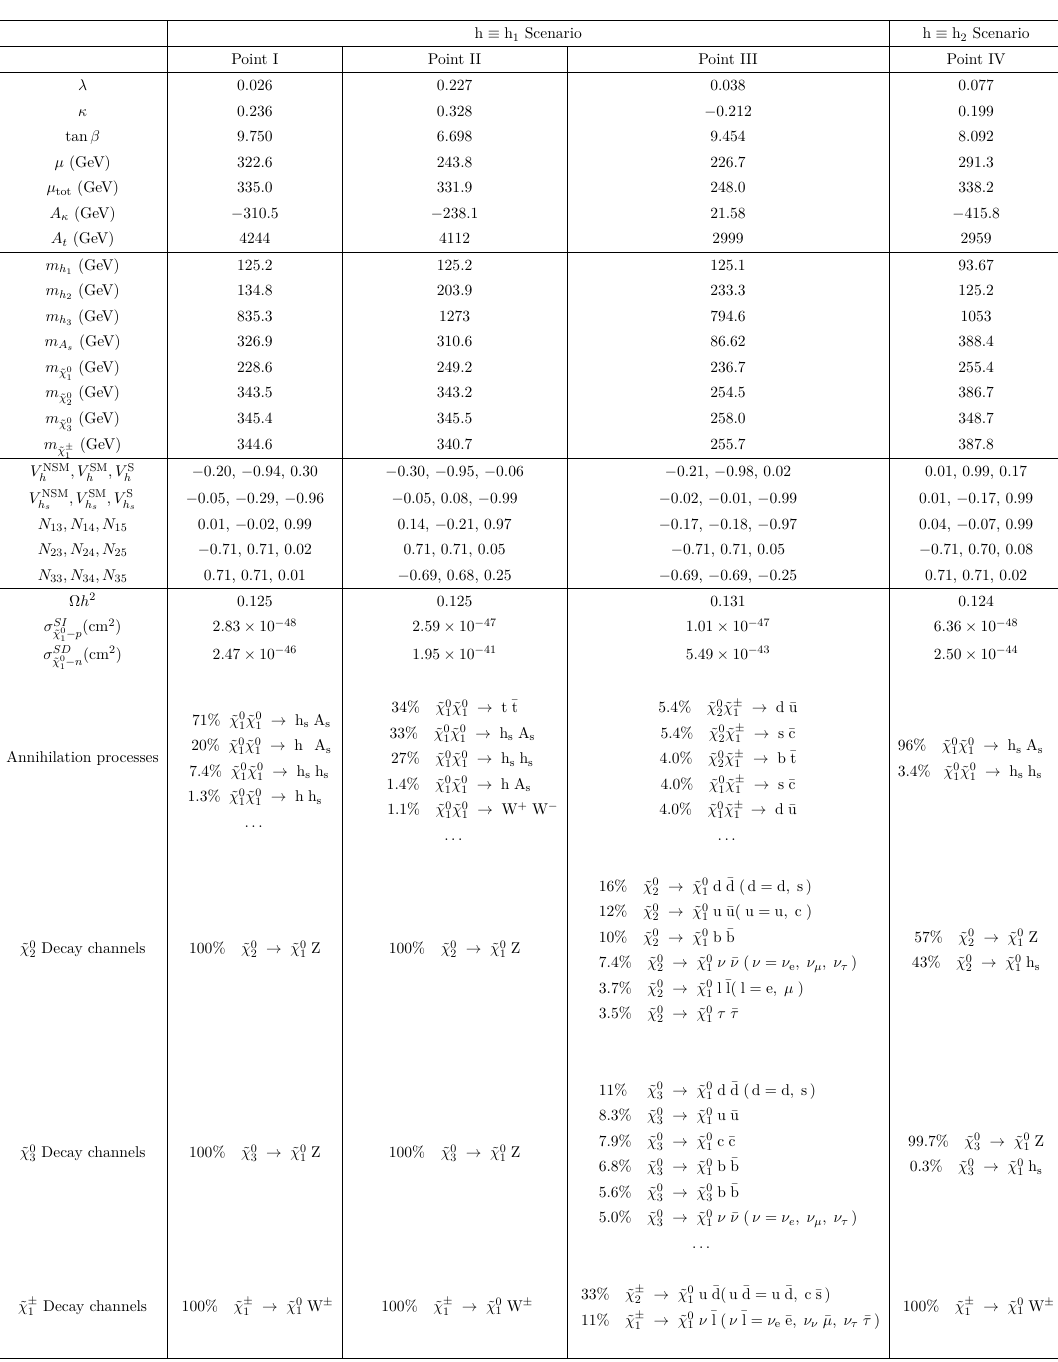
Table 4 . Detailed information of four benchmark points that agree well with all considered ex- periments. Number before each annihilation process represents its fraction in contributing to total DM annihilation cross-section at freeze-out temperature. Number before each decay denotes its branching